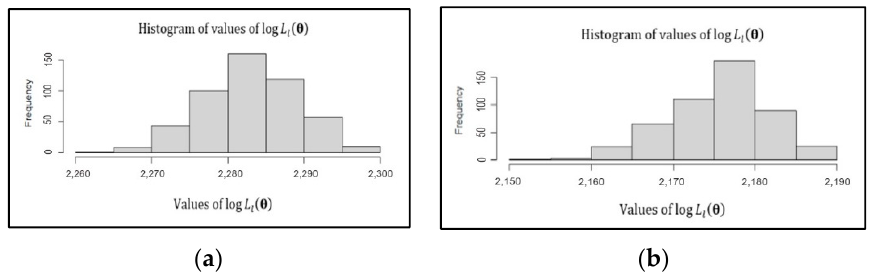
Figure 8. Histogram of values of log𝐿 (cid:3039) (θ), ( a ) for 𝓀 = 500, 𝑚 = 10,𝑙 = 9, 𝑛 = 115; and ( b ) for 𝓀 = 500,𝑚 = 10, 𝑙 = 9,𝑛 = 10.